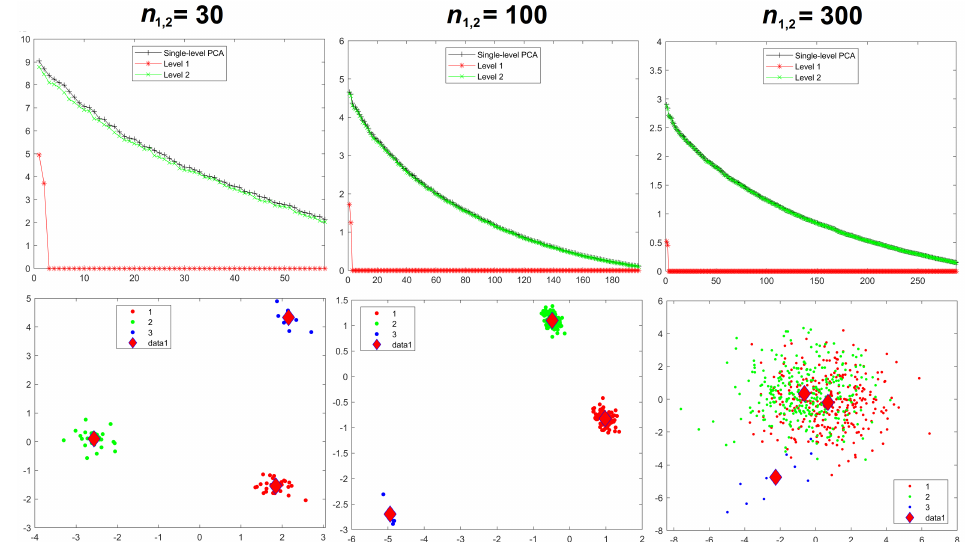
Figure 6. Experiment 2b: eigenvalues ( upper row ) and mPCA, level 1 component scores ( bottom row ) for sample sizes per group of n 1,2 = 30 ( left-hand column ), n 1,2 = 100 ( middle column ), and n 1,2 = 300 ( right-hand column ) in groups 1 and 2. Note that n 3 = 10 in group 3 in all simula- tions for Experiment 2b. Group centroids are shown by the diamonds; x -axis = first component; y -axis = second component. (Results for single-level PCA are as shown in Figure